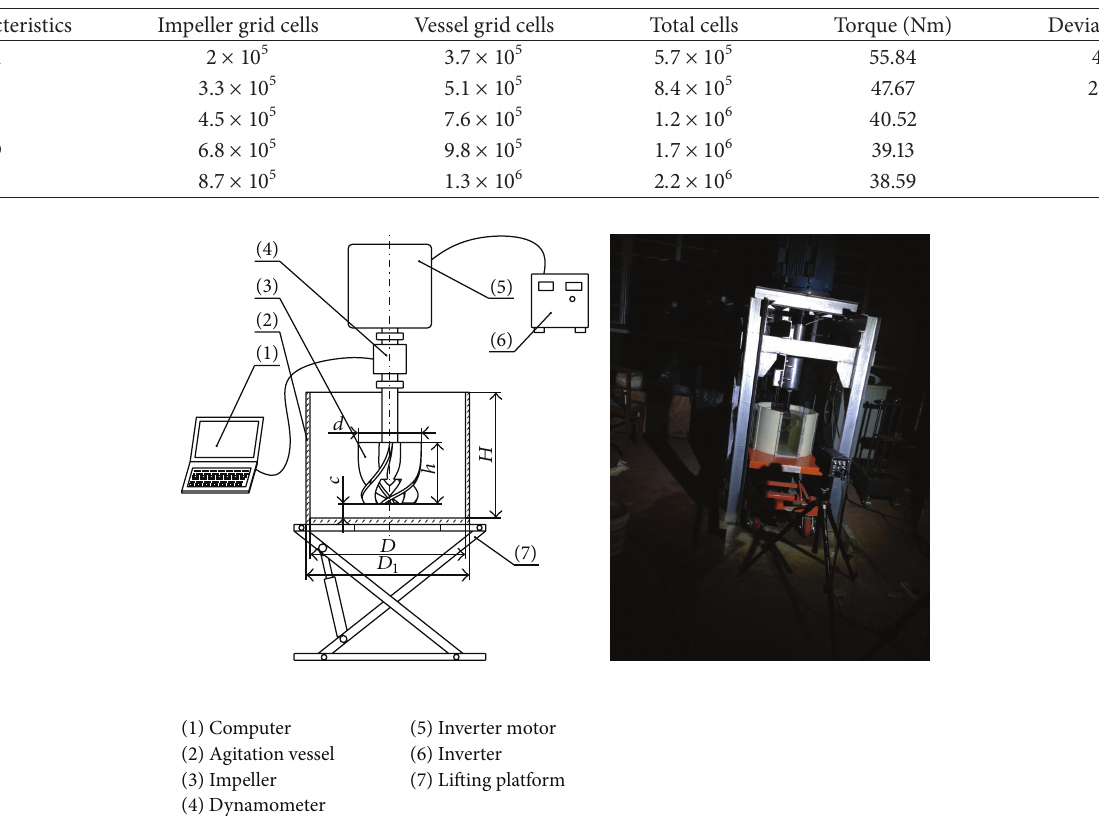
Figure 1: Schematic diagram of the experimental